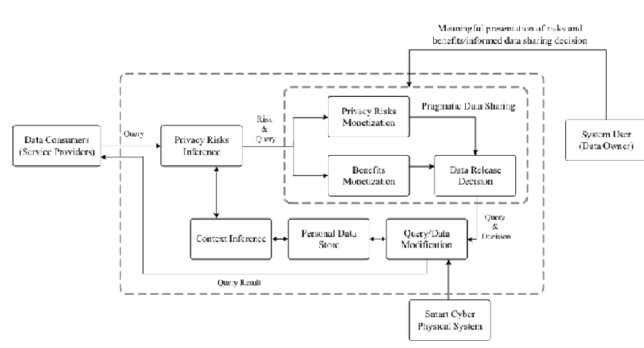
Figure 5. The overview of the framework for privacy